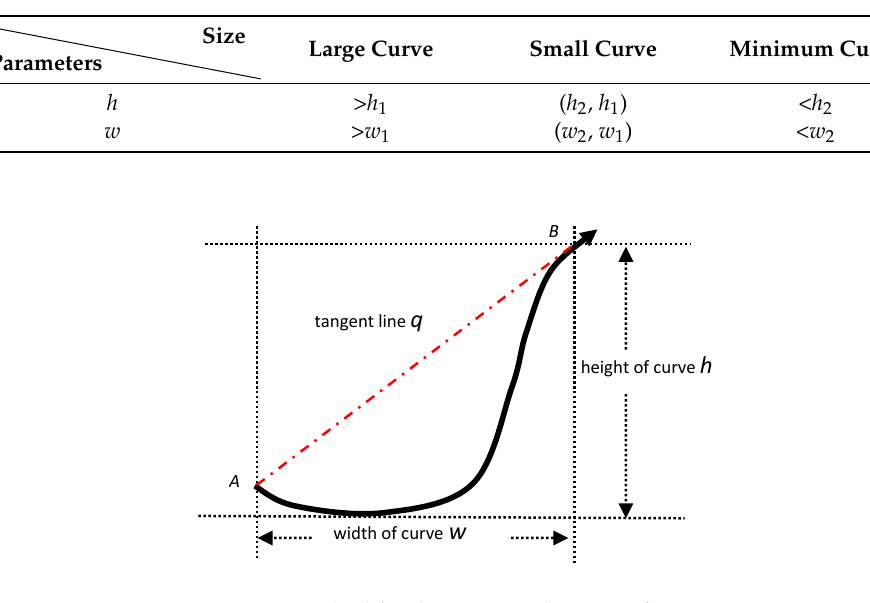
Figure 11. Method for determining the sizes of curves.